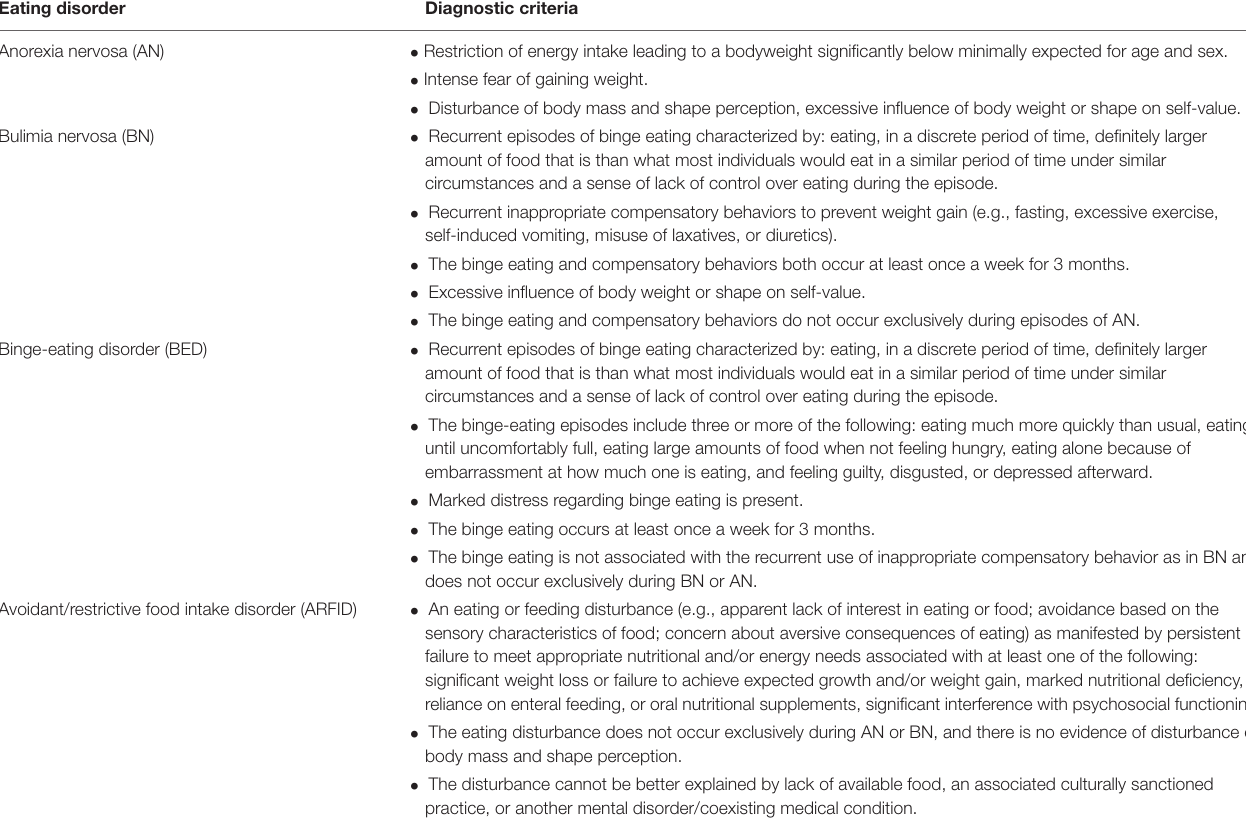
TABLE 1 | Diagnostic criteria for selected eating disorders (1, 3). Eating disorder Diagnostic criteria